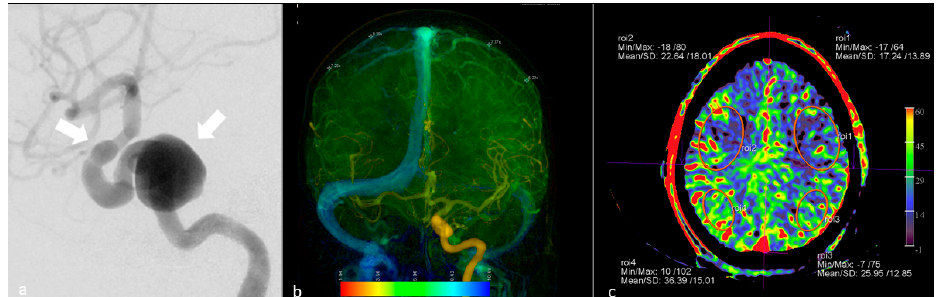
Figure 5. FD CT PBV imaging during test occlusion in a 57-year-old female with internal carotid artery aneurysms. ( a ) Depiction of the aneurysms (white arrows) on a lateral view DSA image. ( b ) Color-coded DSA image in anteroposterior view during test occlusion shows almost synchronous filling of the cortical veins, indicating the patient’s potential tolerance to PVO. ( c ) PBV MIP reformations can be utilized for plotting multiple ROIs in both hemispheres in a standardized fashion.